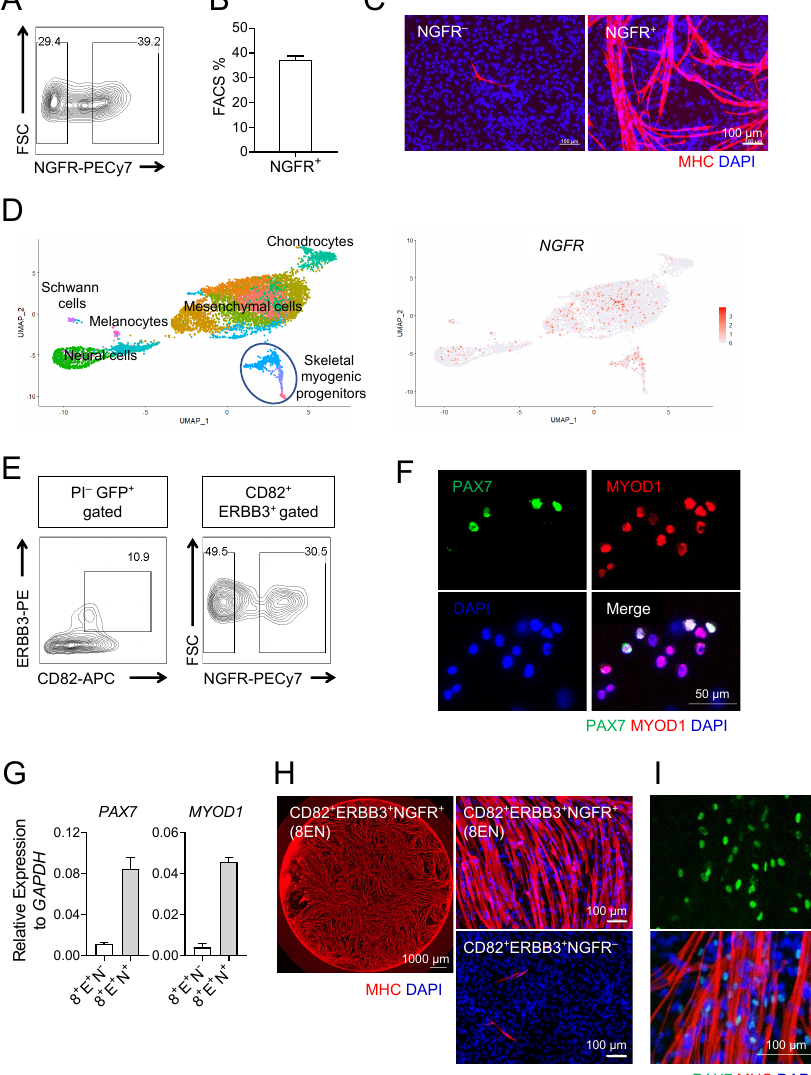
Figure 1. CD82, ERBB3, and NGFR mark the skeletal myogenic population in human H1